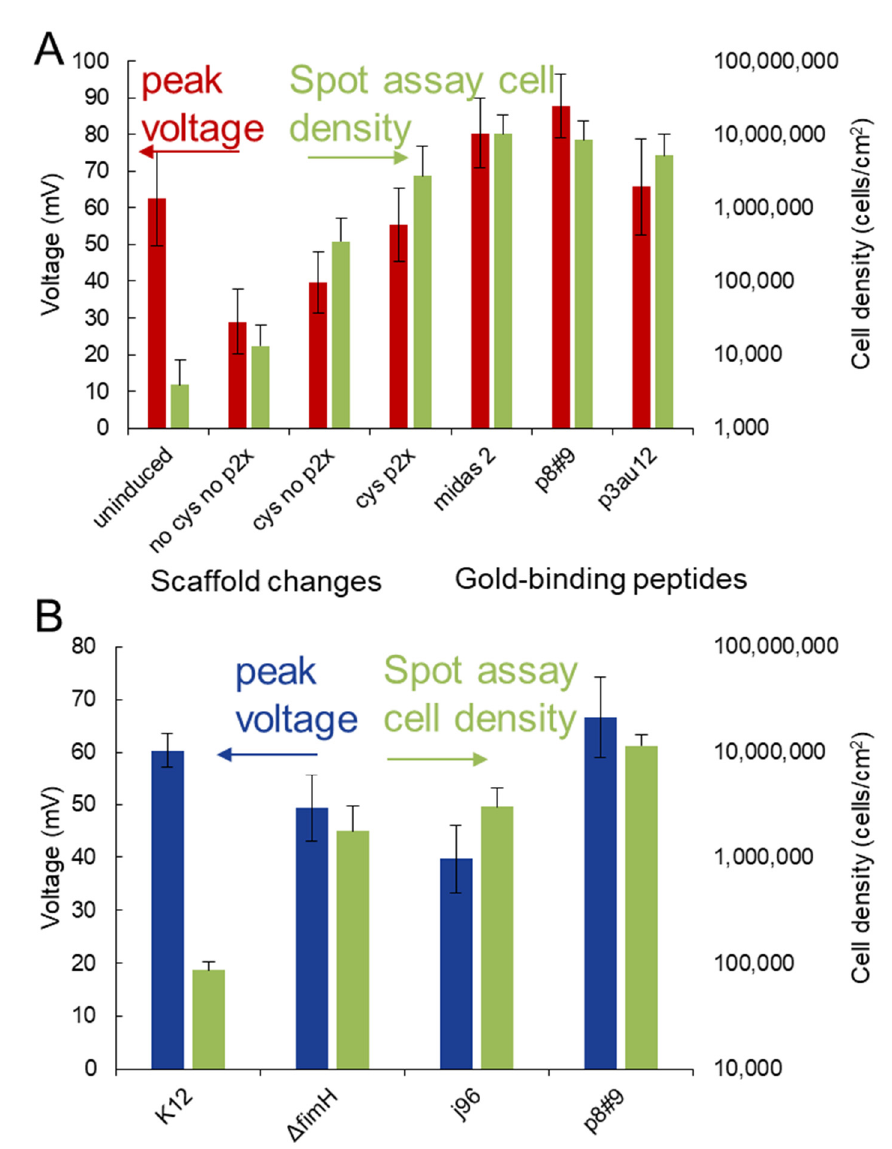
Figure 3. Peak voltages obtained with µL MFCs running at 1 M Ω (left axes, red or blue bars) and cell densities in a binding assay on a gold surface (right axes, green bars). ( A ) Data for cells containing the eCPX scaffold, either uninduced or displaying different versions of the eCPX scaffold; cells displaying literature peptides are in the cys P2X scaffold. ( B ) Data for cells displaying the fimbriae scaffold with and without the FimH tip protein functionalized with the p8#9 gold-binding peptide. The error bars show the standard error (n ≥ 4 for MFCs, n = 3 for cell density).